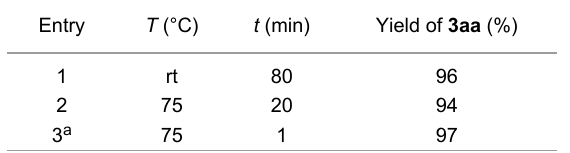
Table 1: Arylation of methyl acrylate ( 1a ) with arenediazonium tosy- late 2a . Study of reaction